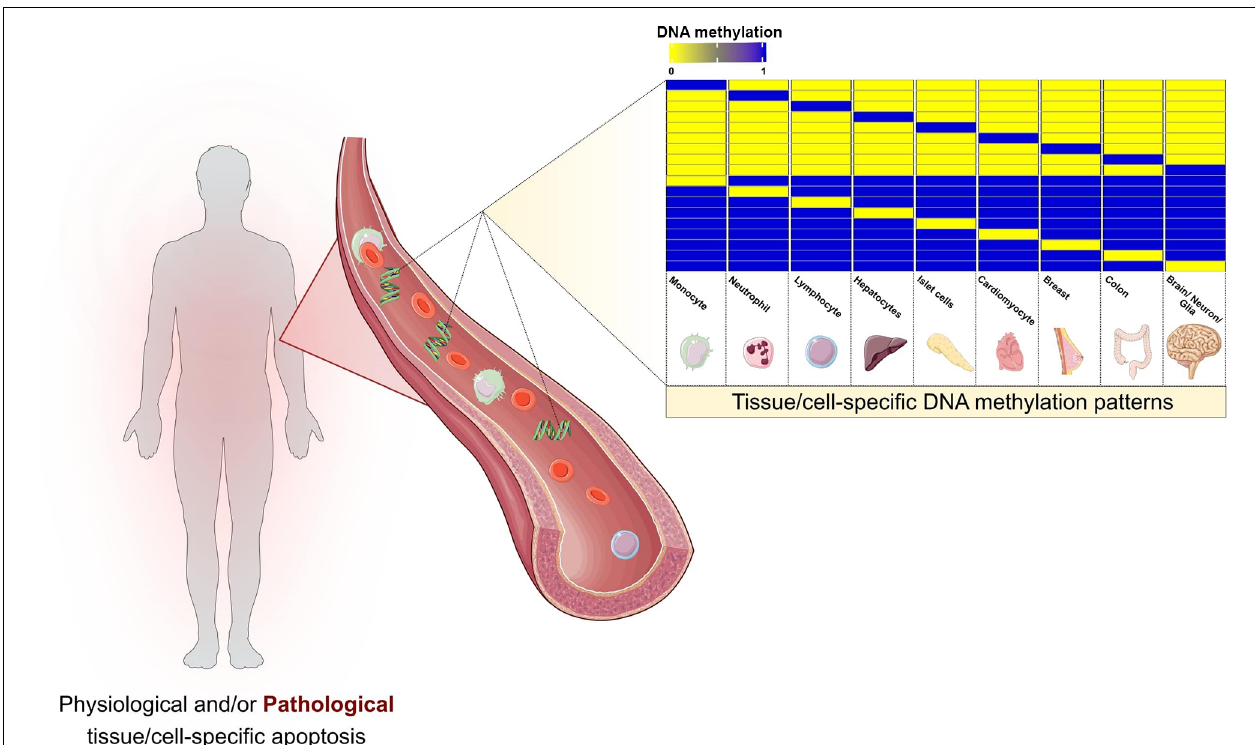
FIGURE 1 | Cell damage and apoptotic events during both physiological and pathological conditions are thought to release cell-free DNA (cfDNA) into the bloodstream. The pool of cfDNA in circulation present specific DNA methylation patterns that would allow the detection and localization of cell death, opening the doors for a wide spectrum of prospective clinical applications. The selected cell and tissue types are intended to be representative. Hematopoietic cells, the main contributors to cfDNA release, are depicted by monocytes, neutrophils, and lymphocytes. Hepatocytes, pancreatic islet cells, cardiomyocytes, breast, and colon are some examples of tissues with previous evidence on the estimation of cell/tissue of origin based on cfDNA methylation. Brain, neurons, and glia represent the potential of applying such pipelines in neurodegenerative